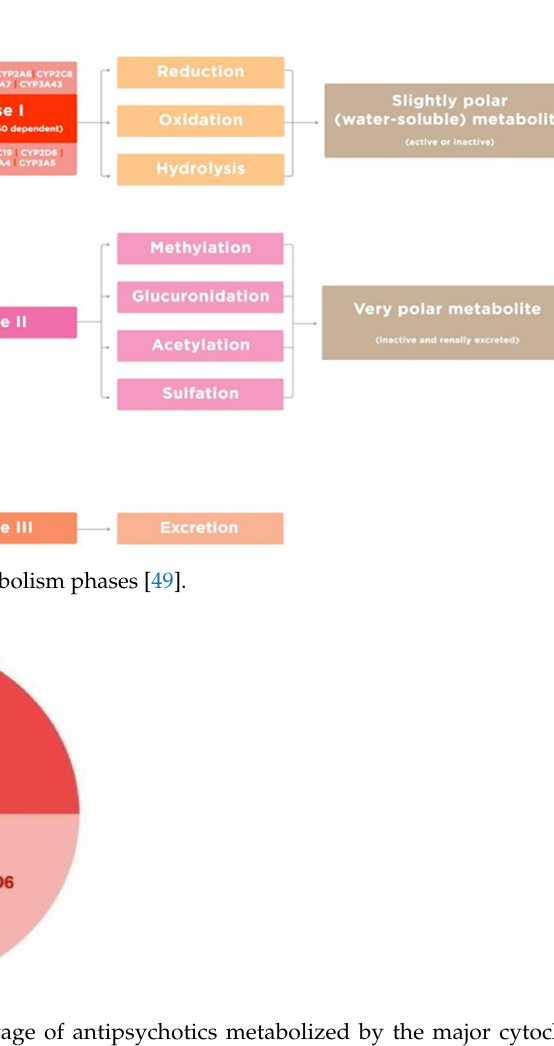
Figure A1. The clinical picture of antipsychotic-induced akathisia (AIA) in patients with schizophre-